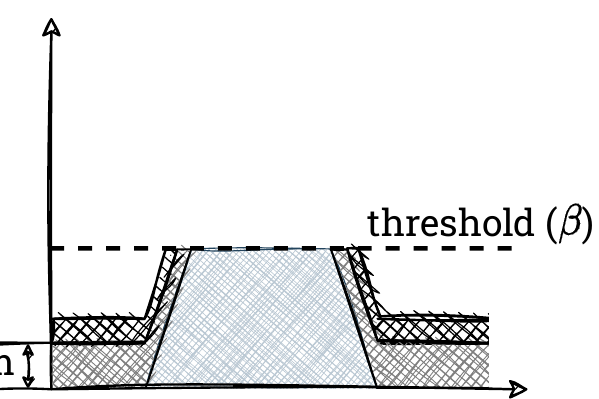
Figure 6. Results of the redistribution procedure: the whole excess is